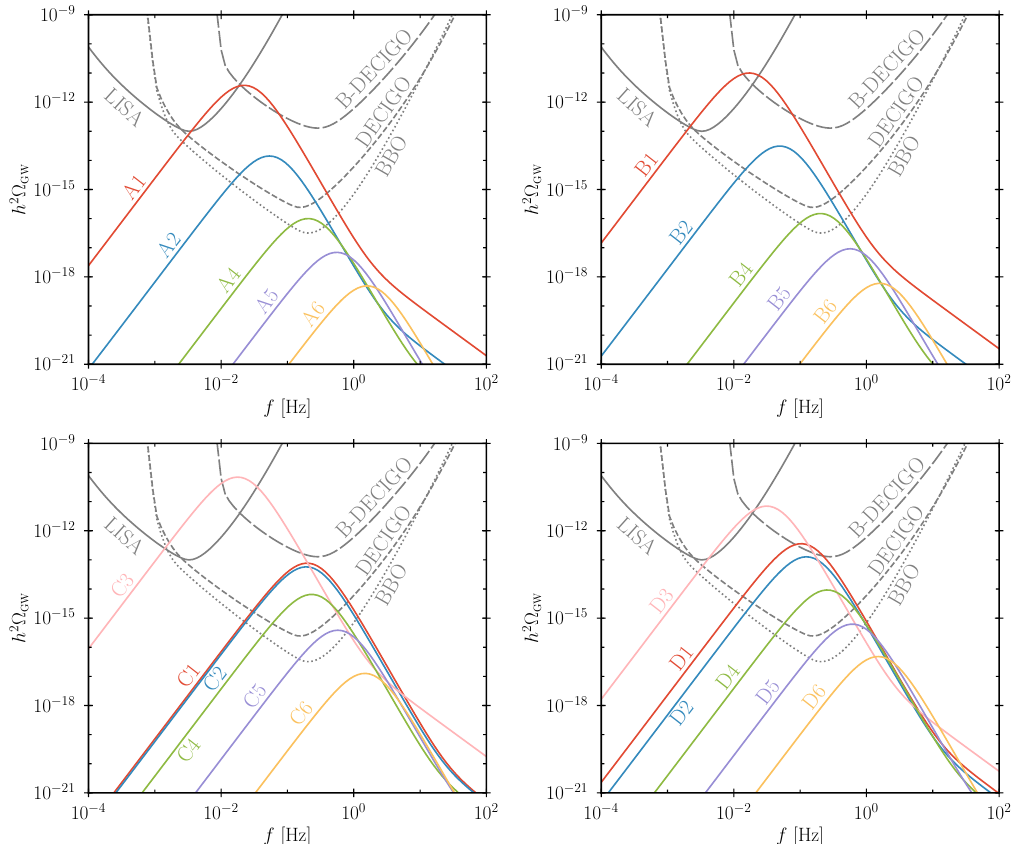
Figure 24 . GW spectra of the benchmark points (colored lines) and power-law integrated sensi- tivity curves for space-based GW observatories (gray